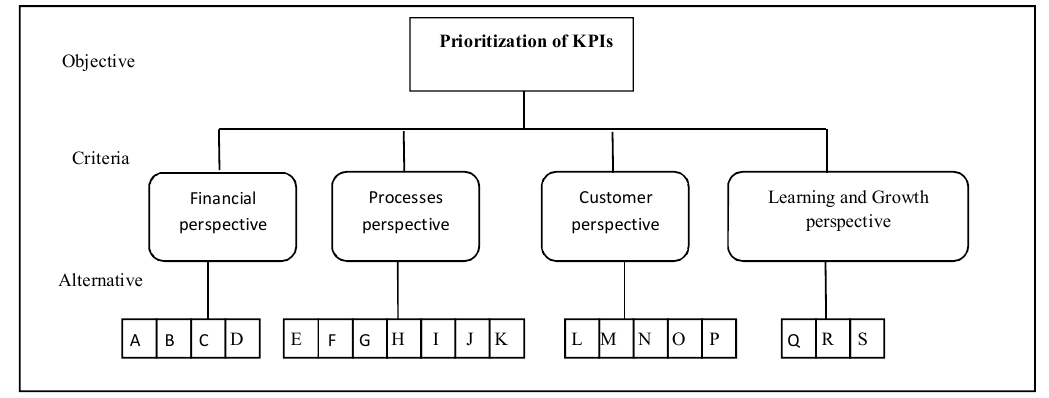
Fig. 2. Hierarchical structure of